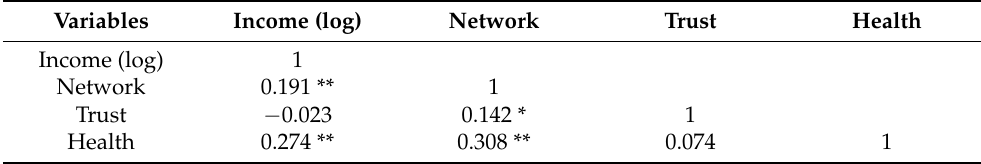
Table 3. Correlation between the major variables.